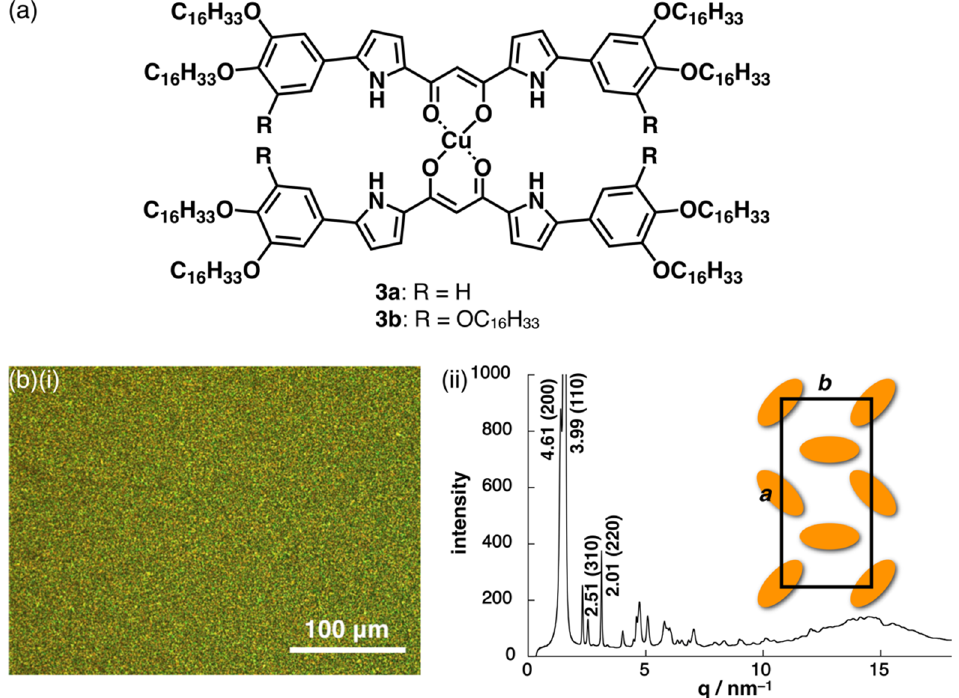
Figure 6. ( a ) Dipyrrolyldiketone Cu II complexes 3a , b and ( b )(i) POM observation and (ii) XRD analysis, with a packing model, of 3a at 90 °C upon